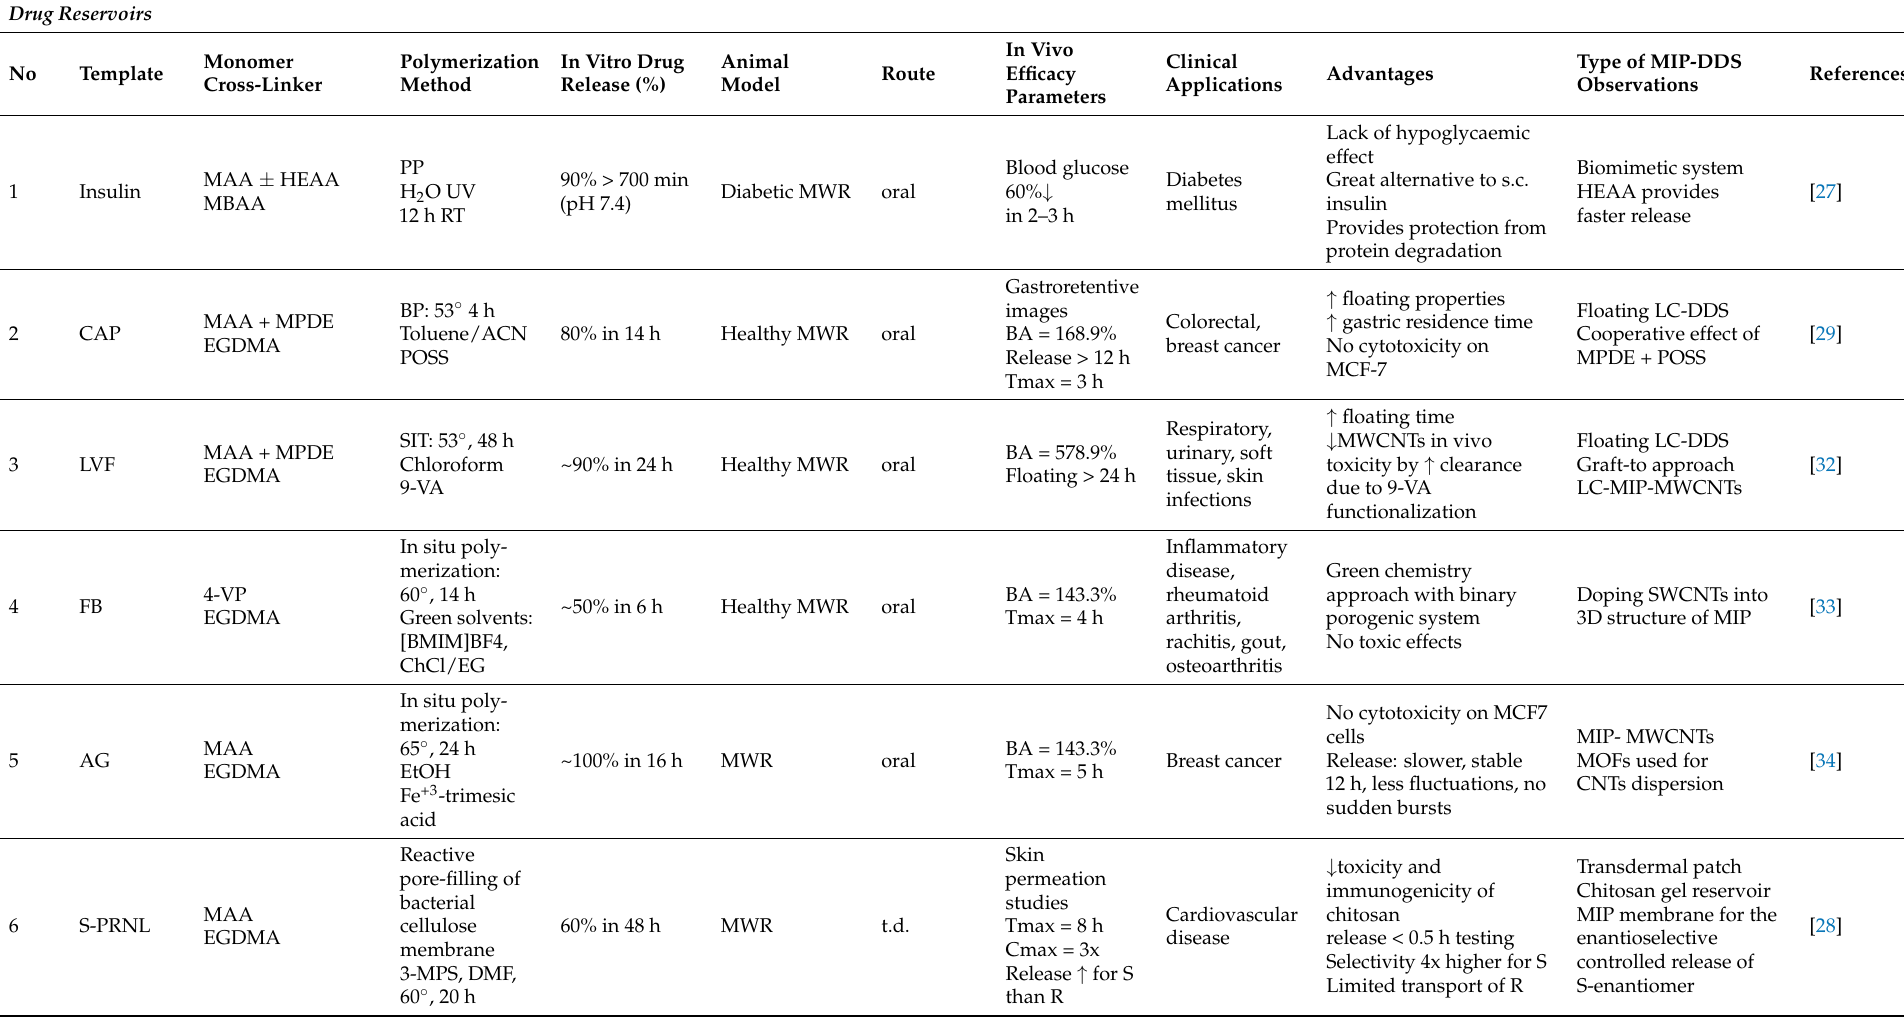
Table 2. Summarized characteristics of MIPs that have reached in vivo